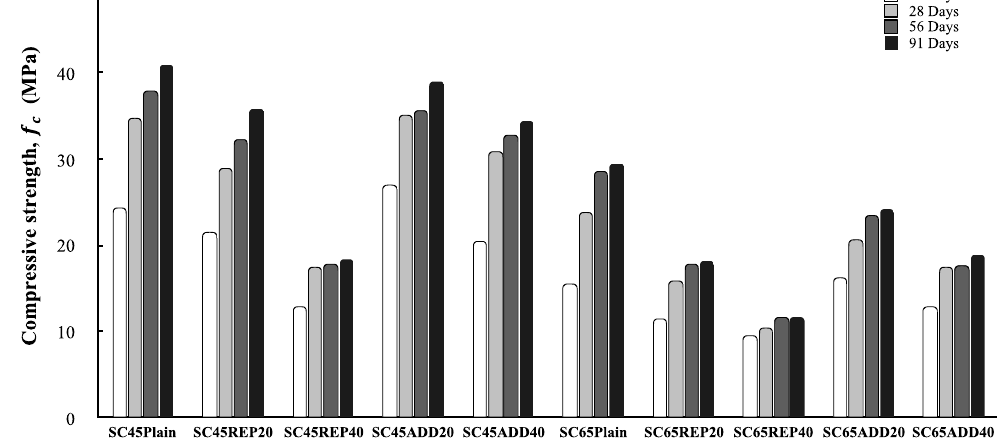
Figure 10. Compressive strength according to the LRM mixing method.